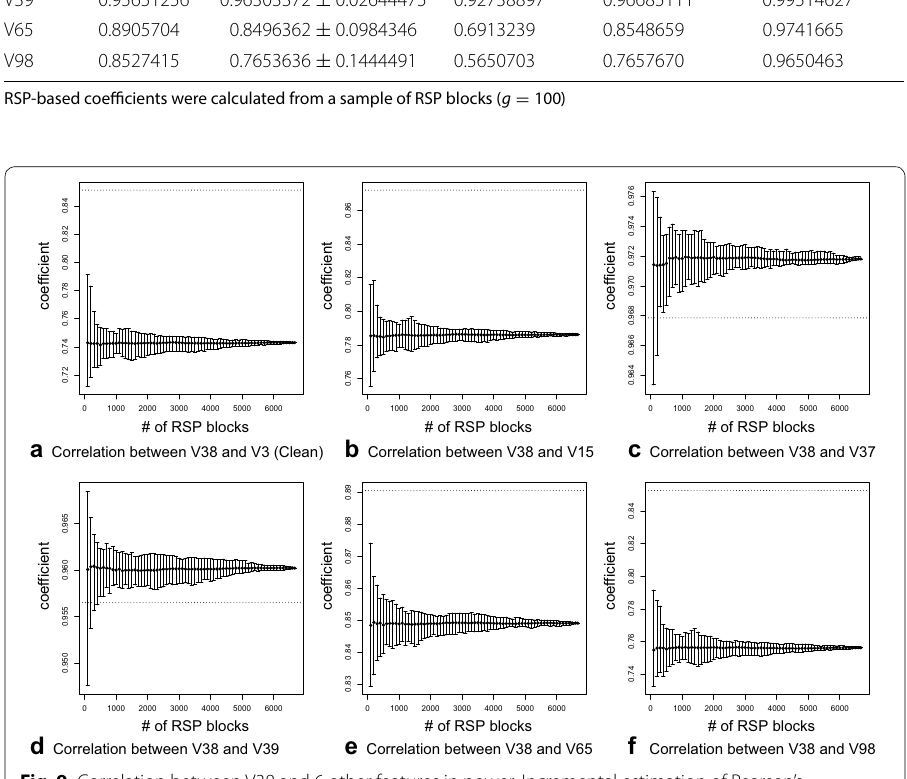
Fig. 9 Correlation between V38 and 6 other features in power. Incremental estimation of Pearson’s correlation coefficients between V38 and 6 other features using samples of RSP blocks of Power data ( g = 100 ). The dotted line in each plot represents the coefficient computed from the entire data